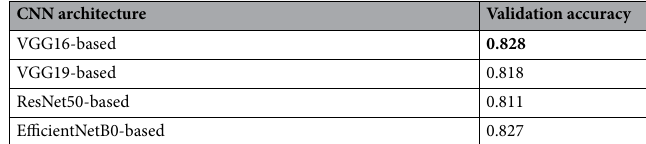
Table 2. Comparison of classification accuracy between CNNs in the EBV + MSI/others task. Each value shows the average accuracy (the average ratio of correct prediction for each 224 × 224 pixels image, ranging from 0.0 to 1.0), obtained by fourfold cross-validation. The highest accuracy is indicated in bold. CNN, Convolutional neural networks; EBV, Epstein-Barr virus; MSI, Microsatellite